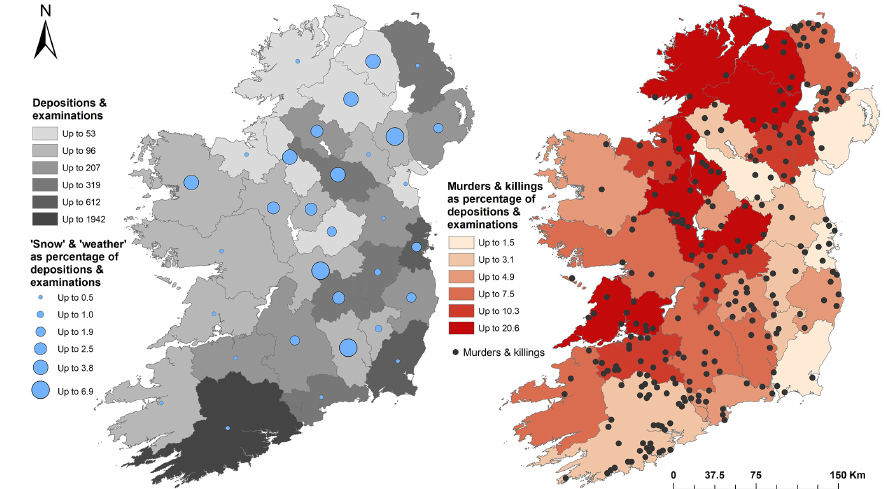
Figure 10. Geography of reported severe weather and murders and killings during the 1641 Rebellion in Ireland. More specifically, the left panel shows total Depositions and related documents per county (gray shading) as listed on https://1641.tcd.ie/ (last access: 10 October 2015). The percentage of these referencing “snow” and severe “weather” are shown in graduated blue dots and broadly follow a climatologically credible pattern, with greater percentages in more northerly counties as well as the midlands, which lack the moderating influence of the Atlantic on temperatures. Right panel: murders and killings reported in the Depositions (taken from Smyth, 2013) are shown as black dots and expressed as a percentage of total Depositions per county (red shading). Gradation into intervals in both maps employs Jenks natural breaks. Figure redrawn after Ludlow and Crampsie